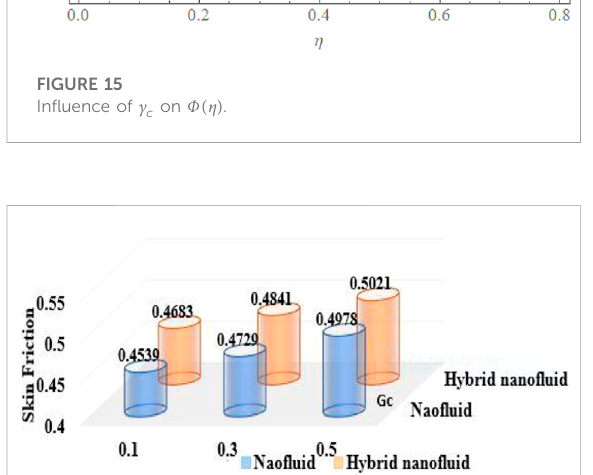
FIGURE 16 Gc vs skin friction.